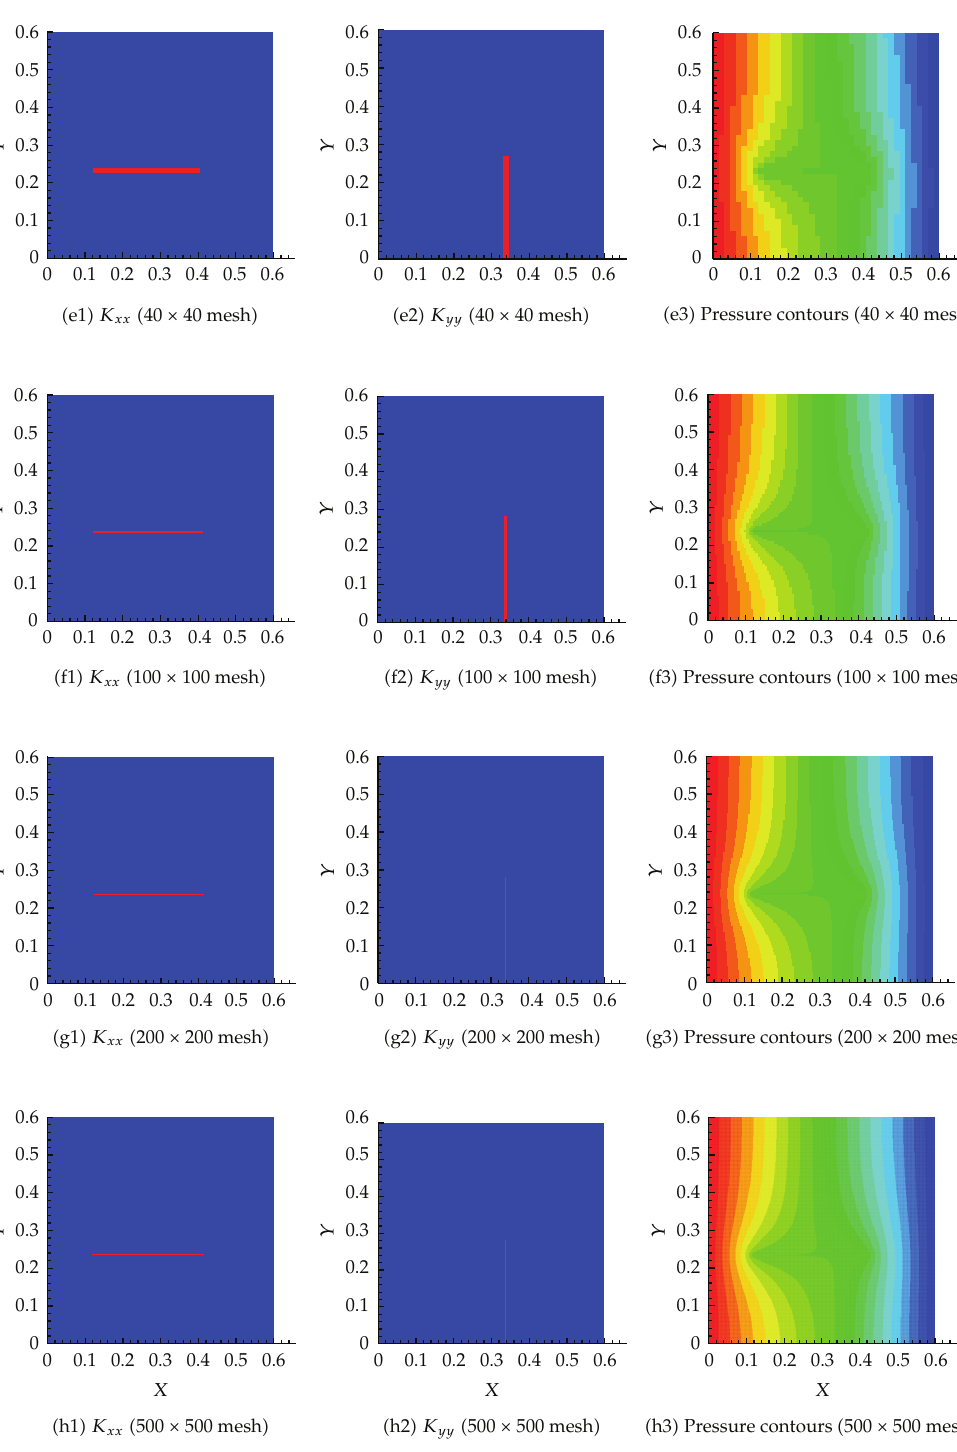
Figure 6: E ff ective permeability and pressure contours for the 2 fractures scenarios for di ff erent degrees of